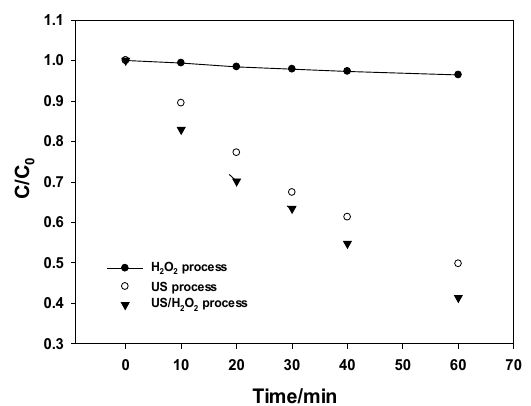
Figure 3. Comparison of the kinetics in each process. H